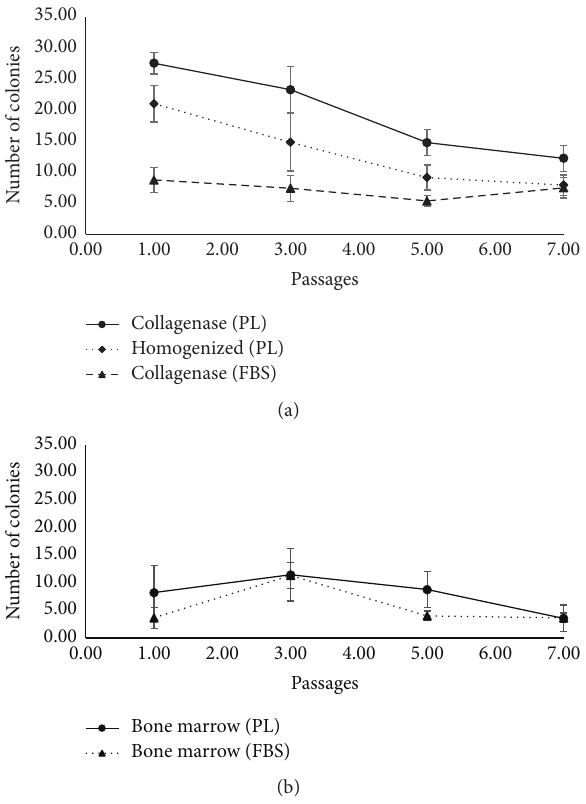
Figure 4: Umbilical cord MSCs possess robust self-renewal capa- bility. Graphical representation of mean CFU-F content of MSCs, at different passages, generated by plating 100 cells per well from (a) umbilical cord and (b) bone marrow. Error bars denote mean ±